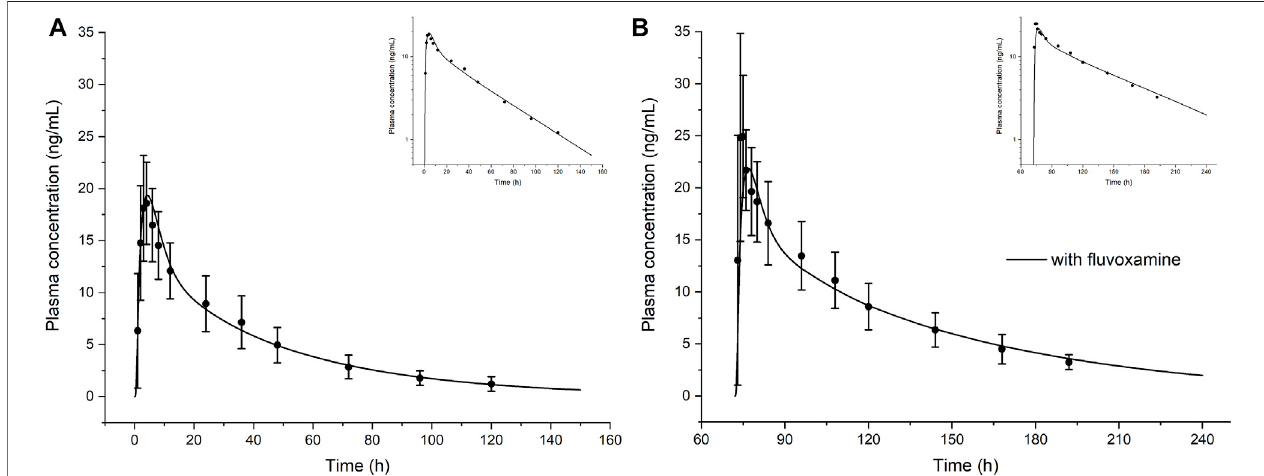
FIGURE 3 | The model-simulated concentration-time curve of olanzapine after a single oral dose of 10 mg in healthy volunteers in the absence (A) or presence (B) ofco-administeredCYP1A2inhibitor fl uvoxamine.Curvesarefromthemodelpredictionandobservedmeanplasmaconcentrationswithstandarddeviationsareshown as circles with error bars. The top right corners show the log scale fi gures. Figure B calculated the actual sampling time starting from day 4 that was different from the original literature.